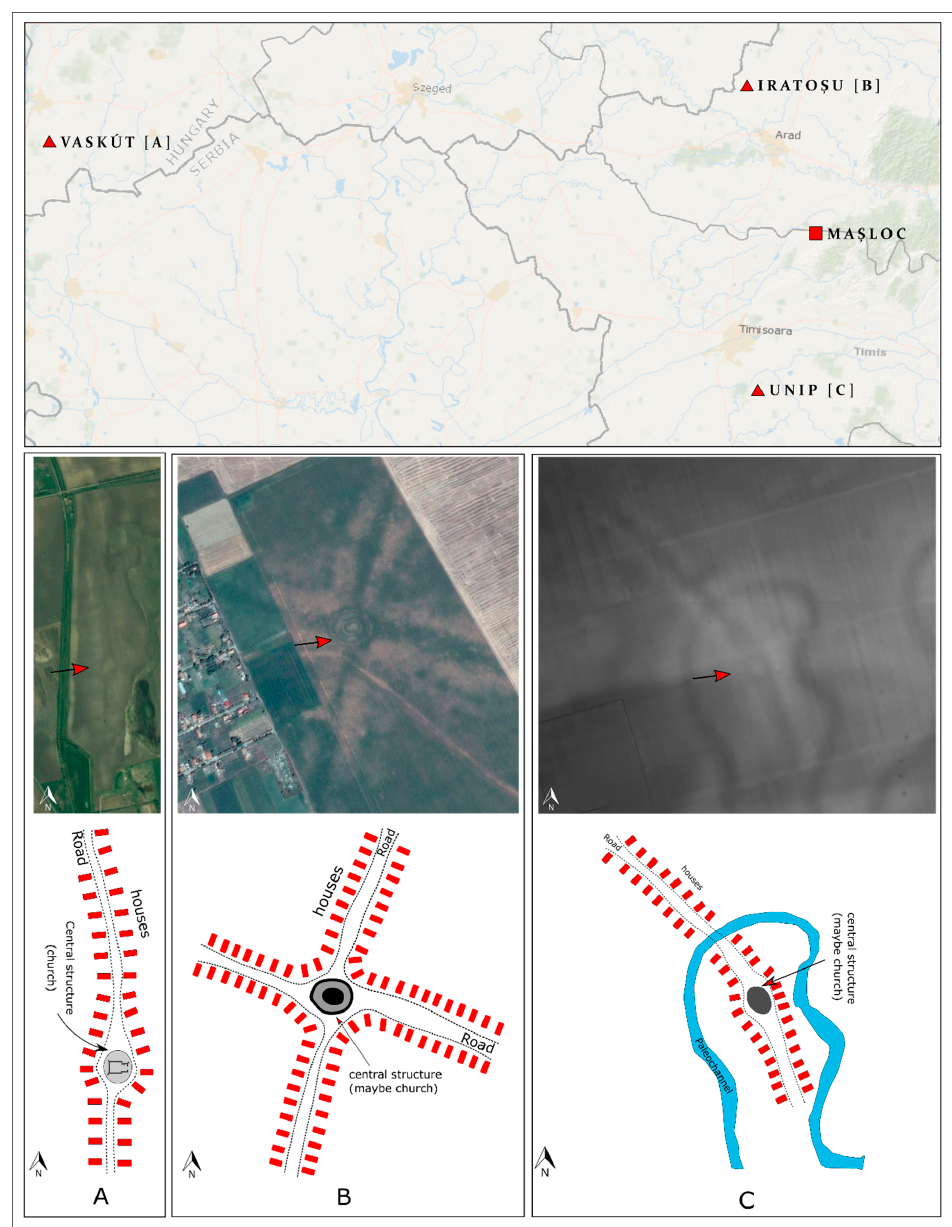
Figure 15. Top image: Location of the discussed medieval village; ( A ) The medieval village of Arany as seen on a Google Earth satellite image of 04 November 2011 and the corresponding sketch that represents the layout of the village ( B ) Iratos u medieval village. Google Earth satellite image from 13.08.2013 (the outline of the medieval village is visible as a cropmark) and a hypothetical sketch of the medieval village based on this. ( C ) Unip medieval village. LiDAR DEM 1 m resolution. The full extent of the village layout together with the central structure can be traced from Google Earth satellite images (see for example captures of 5.10.2009 and 5.5.2014) and the LiDAR Dem.